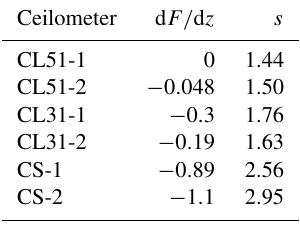
Table 4. Relevant criteria of the validation for Case A. The mini- mum slope d F/ d z for an integer wavelength is given, or d F/ d z = 0 if the corresponding curve shown in Fig. 12 crosses the zero line (for an noninteger wavelength). According to Eq. (17) the decrease in the range-corrected signal s should be 1 . 35 < s < 1 . 45. A height- dependent κ(z) is assumed. Ceilometer d F/ d z s CL51-1 0 1.44 CL51-2